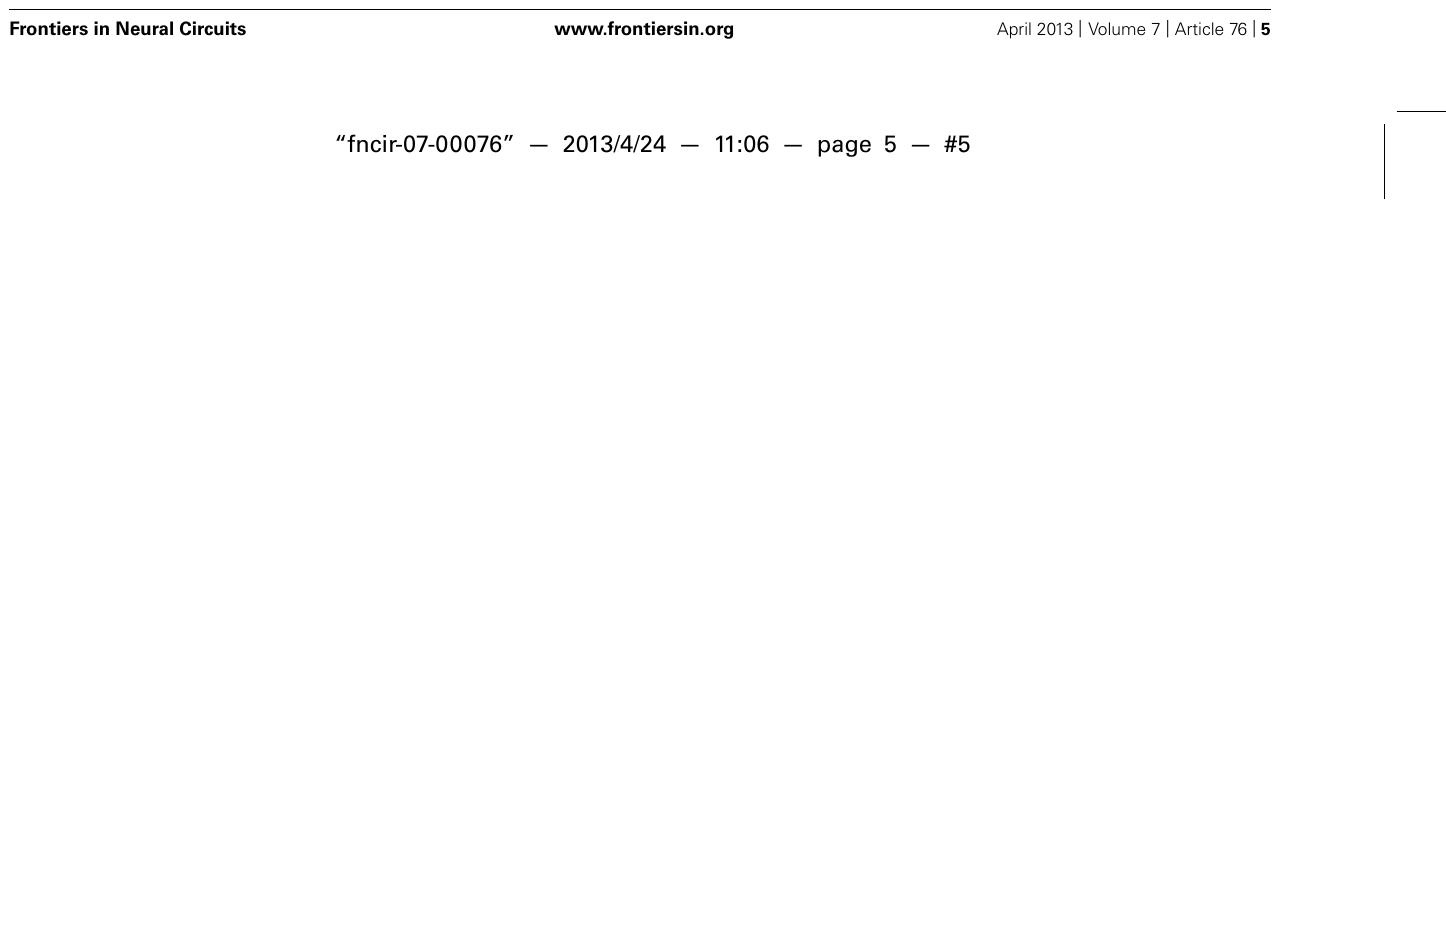
BrdU (green) and DAPI (cyan) markers.White dashed line depicts midline. (D) Genetically specified circuit analysis. Synaptophysin-eGFP (syp-eGFP) allows imaging of structural plasticity of synapses (white arrowheads) in hypocretin (HCRT) neurons. (E) Single synapse resolution projection of array tomography sections stained for GFP (green), PSD95 (magenta) and Synapsin (cyan). Inset, magnification of a single shaft synapse (white